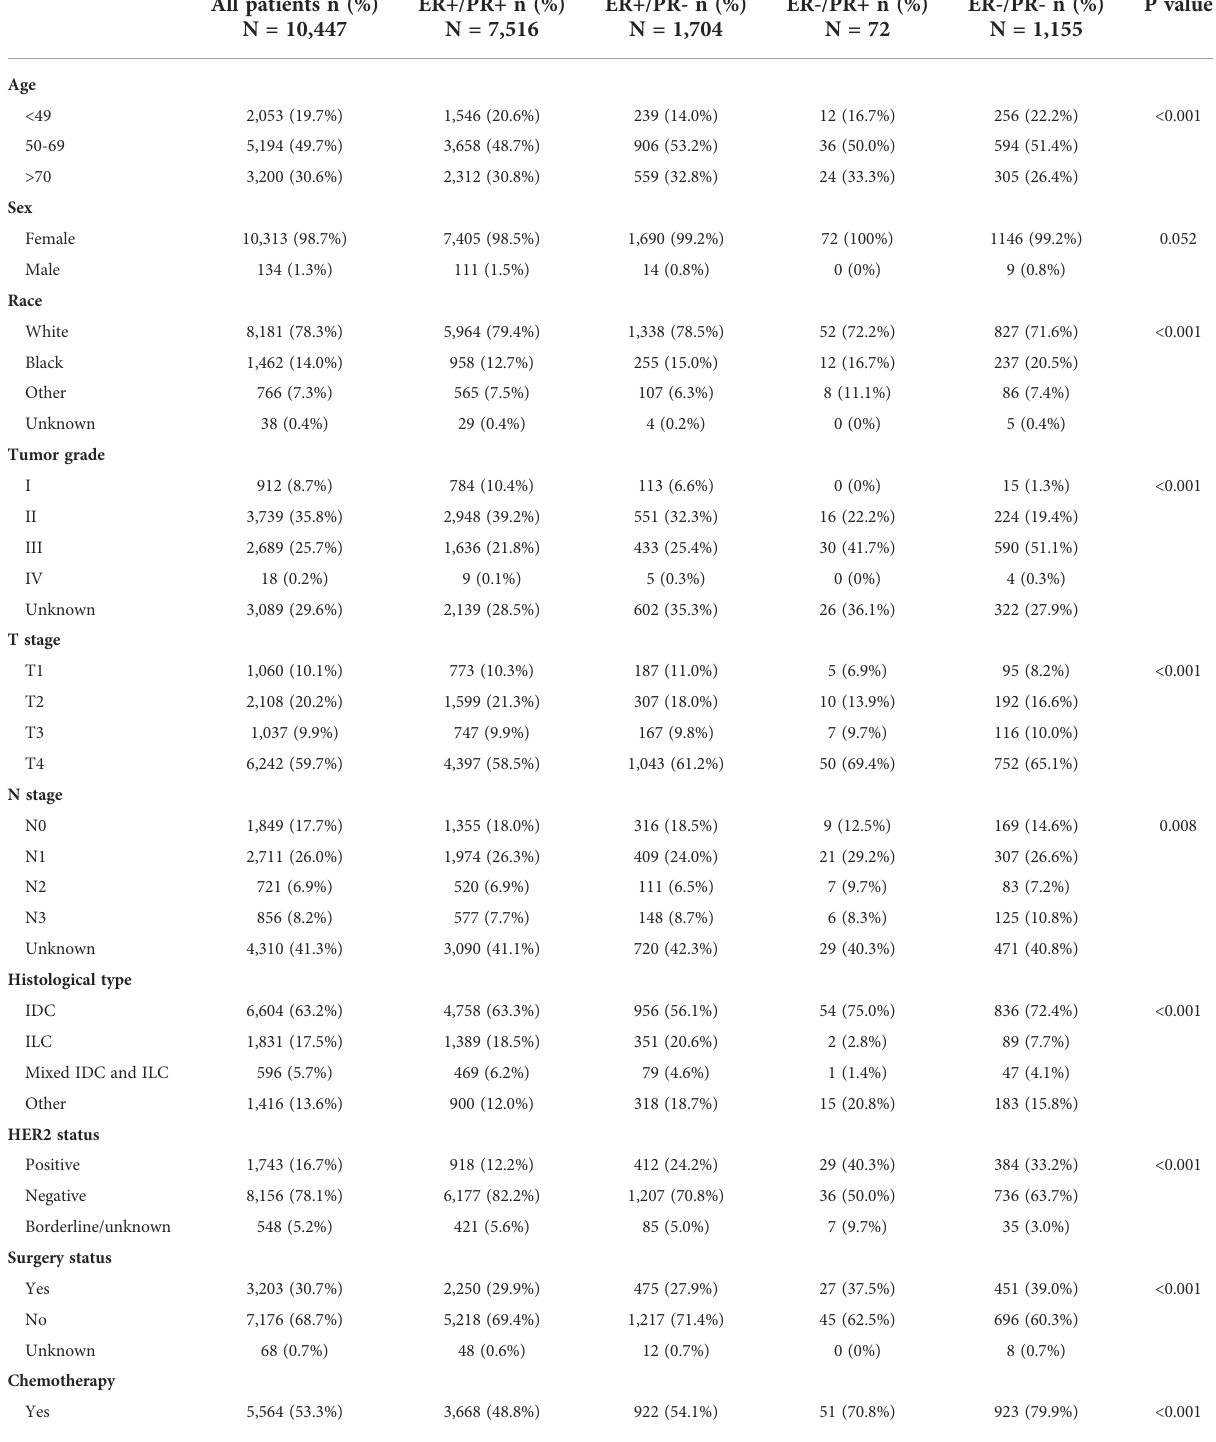
TABLE 2 Demographic and clinicopathological characteristics of breast cancer patients with bone metastasis strati fi ed by hormone receptor